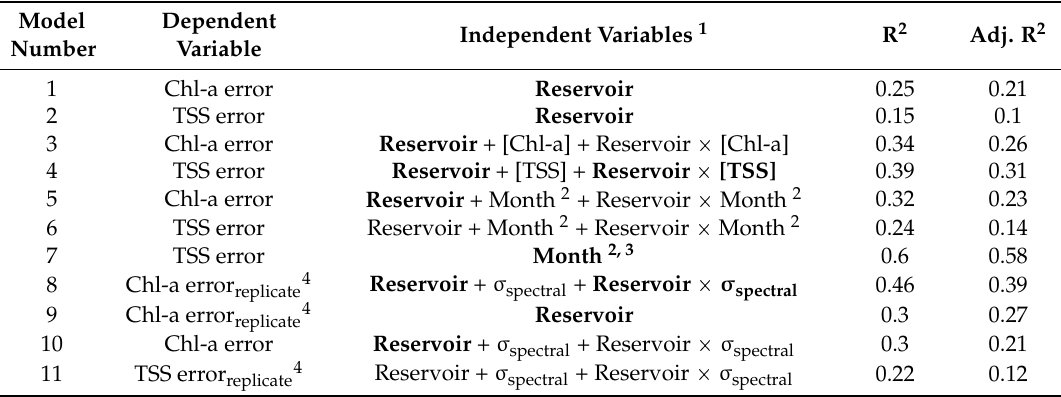
Table 5. Linear statistical models used to partition sources of algorithm